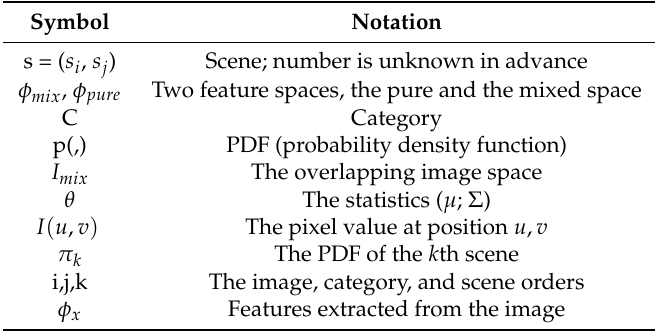
Table 1. Symbols and